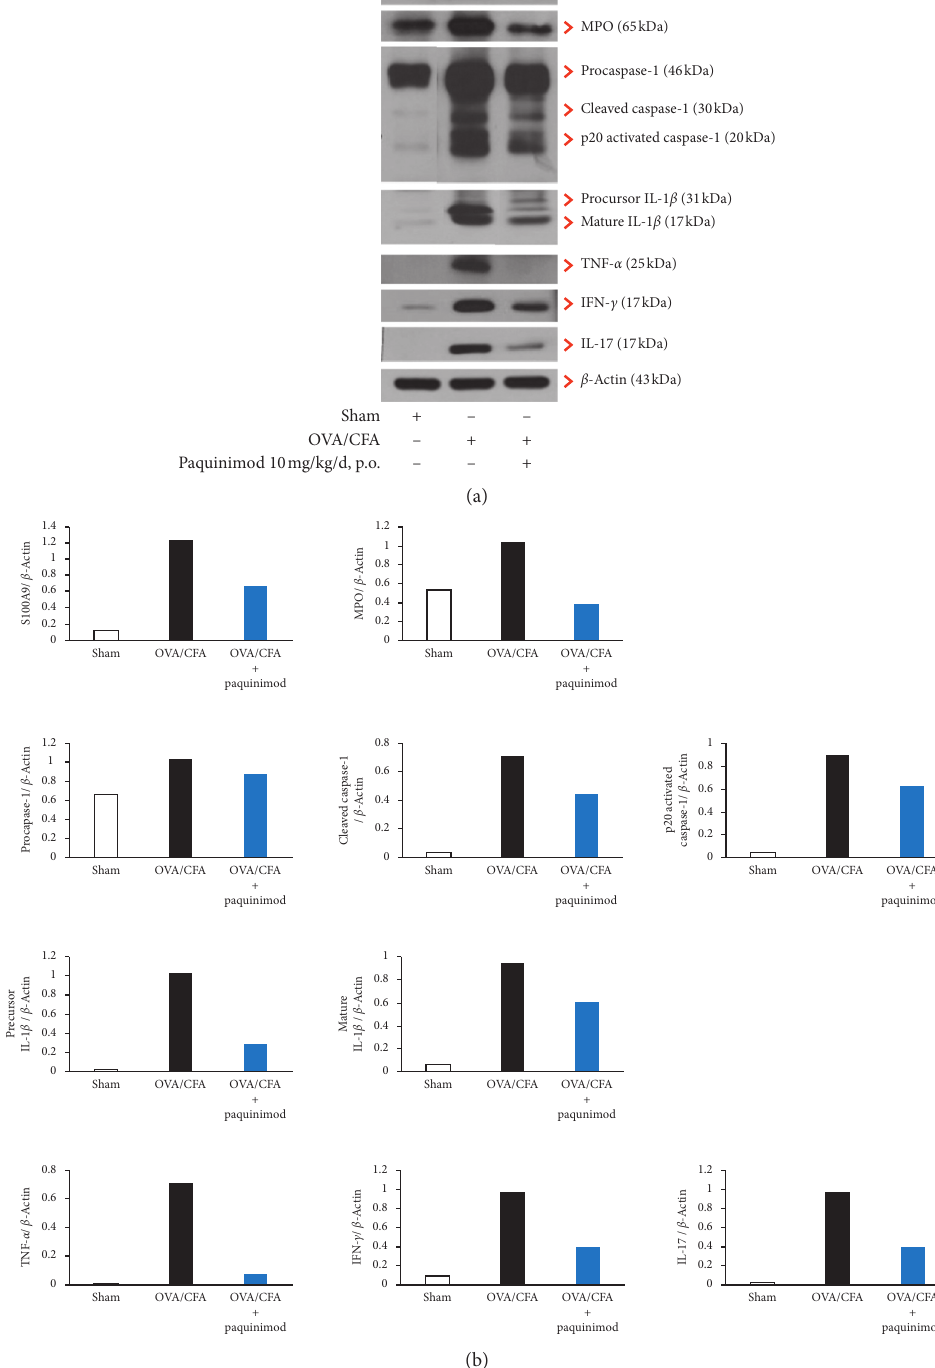
Figure 4: Western blot of inflammasomes, S100A9, and cytokines in mice lung lysates. (a) A representative figure of western blot of S100A9 (13kDa), procaspase-1 (46 kDa), cleaved caspase-1 (30kDa), p20 activated caspase-1 (20kDa), precursor IL-1 β (31 kDa), mature form IL-1 β (17kDa), MPO (65 kDa), IL-17 (18kDa), IFN- c (17kDa), and TNF- α (25kDa) performed on the pooled lung lysates from sham-treated ( n � 3), CFA/OVA-treated mice ( n � 3), and CFA/OVA plus paquinimod (10mg/kg/d, p.o.) ( n � 3) (b) and their densitometry of the western blot band intensity normalized to that of β